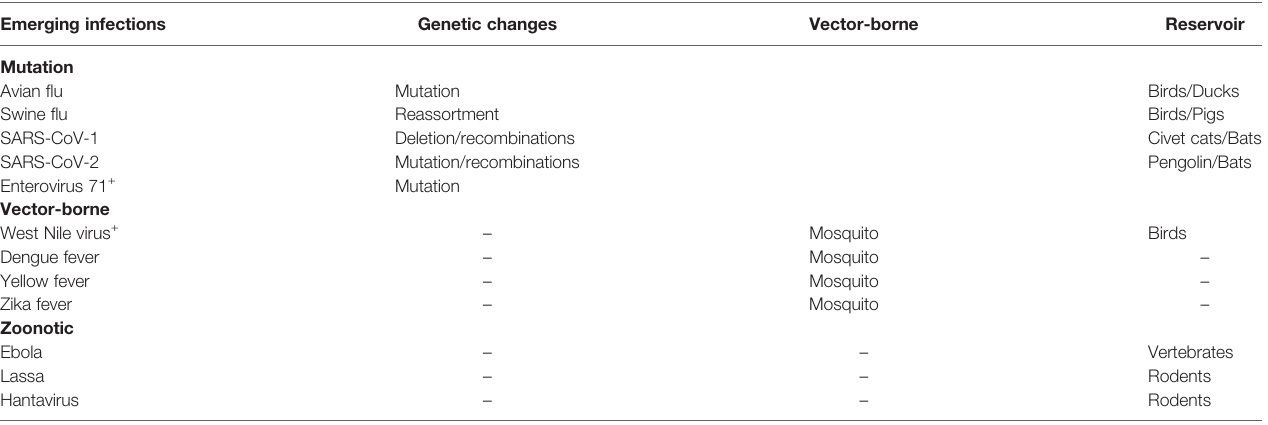
TABLE 1 | Evolution of the outbreaks of common emerging infections. Emerging infections Genetic changes Mutation Avian fl